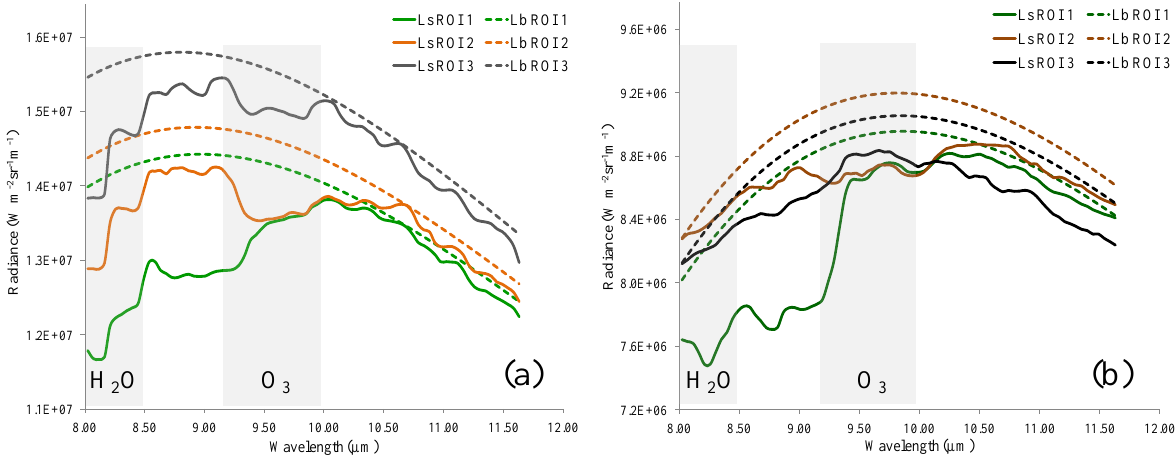
Figure 2. At-sensor radiance (Ls; solid curves) and fitted tangent blackbody radiation (Lb; dashed curves) of three ROIs (representing the three sites from Figure 1b) in ( a ) day and ( b ) night images. Gray shading marks the absorption ranges of water vapor (H 2 O) and ozone (O 3 ).